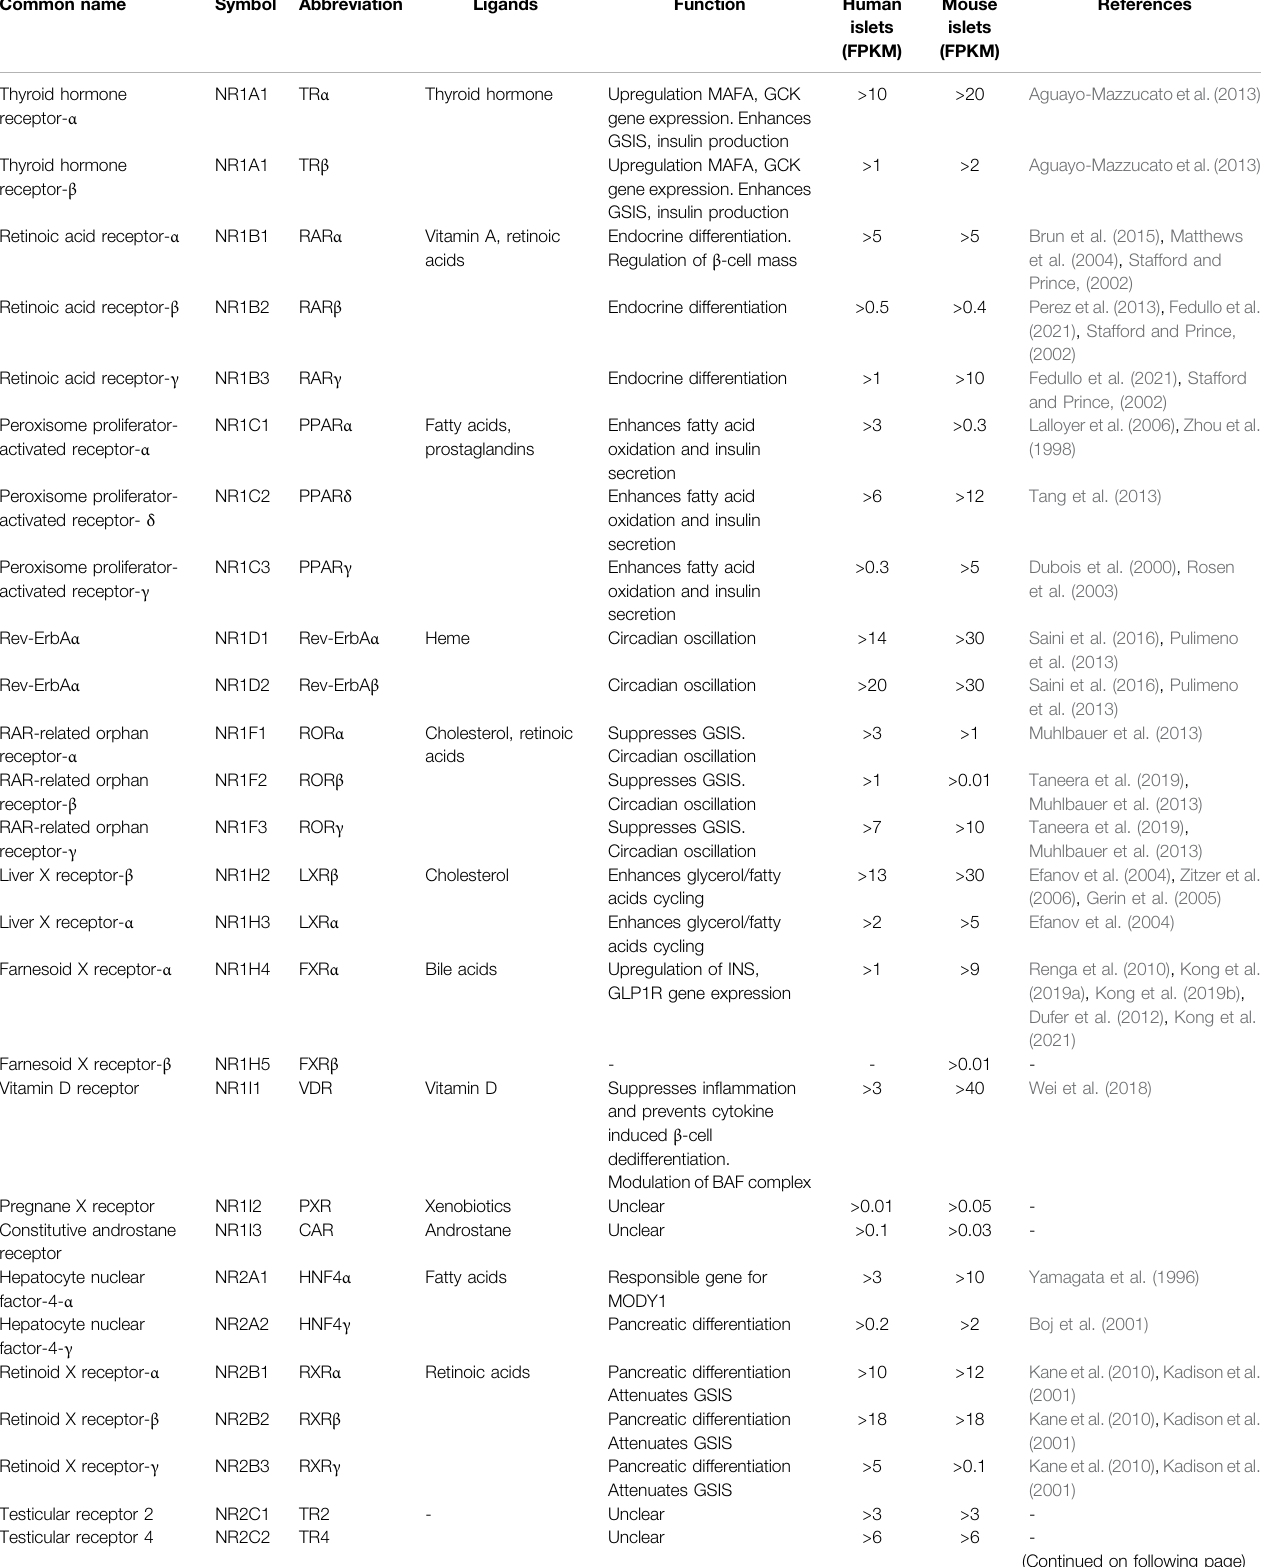
TABLE 1 | Physiological role of nuclear receptors in functional β